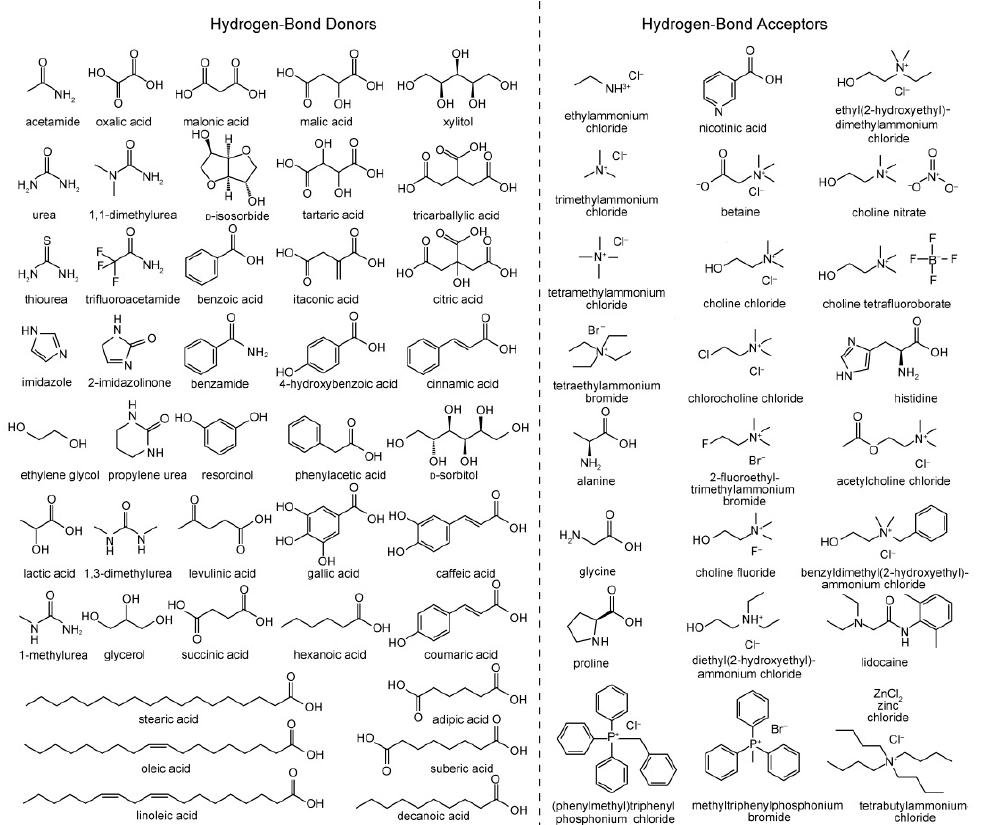
Figure 1. Common hydrogen bond donors (HBDs) and acceptors (HBAs) used in the preparation of various deep eutectic solvent (DES) systems. Reproduced with permission from [10], Copyright 2013, John Wiley and Sons.